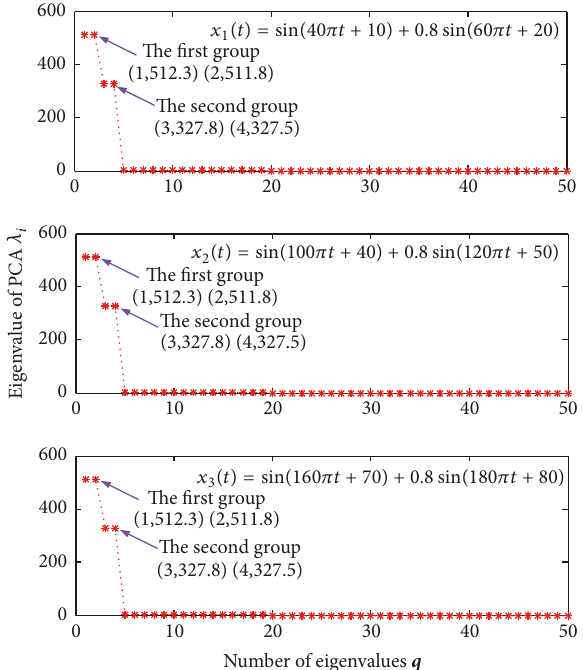
Figure 2: Eigenvalues distribution of covariance matrix C with two frequency